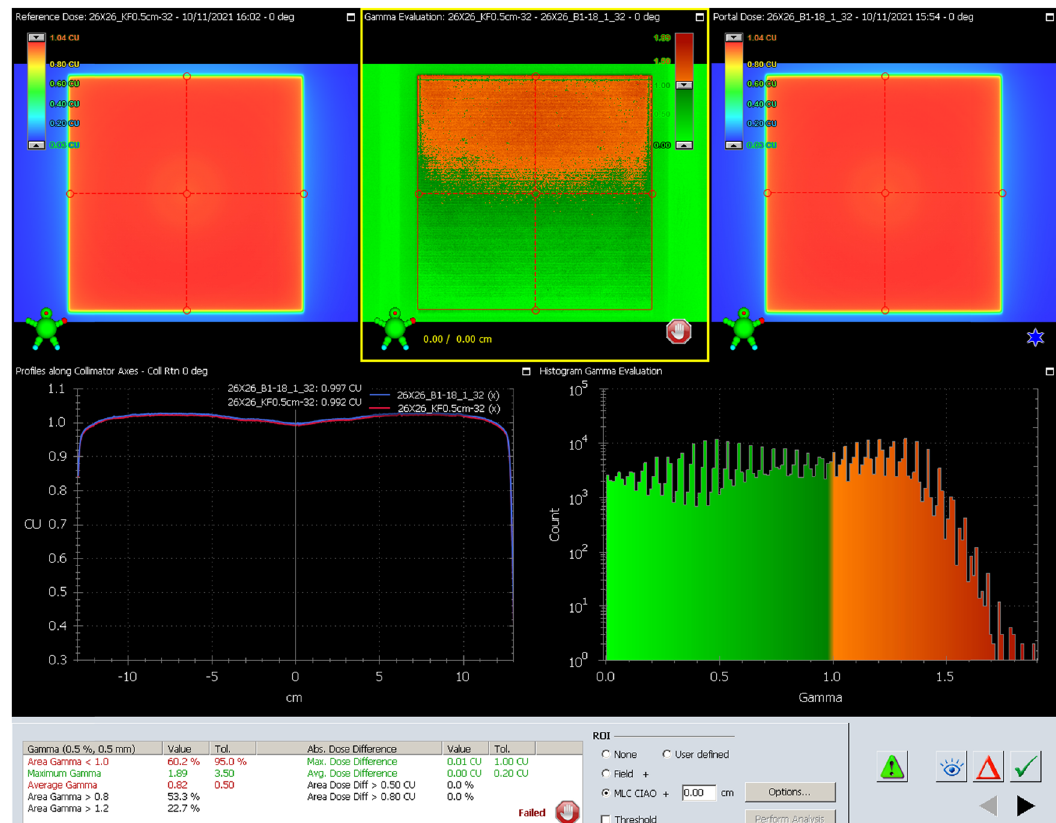
Figure 3: The view of Portal Dosimetry software to analyse the tissue or water equivalence of bolus materials ( portal dose images of 0.5 cm RW3 slab water - equivalent phantom on the upper left, portal dose images of the compared bolus material on the upper right, blended image of gamma evaluation in upper middle and gamma evaluation result of compared bolus in lower left )